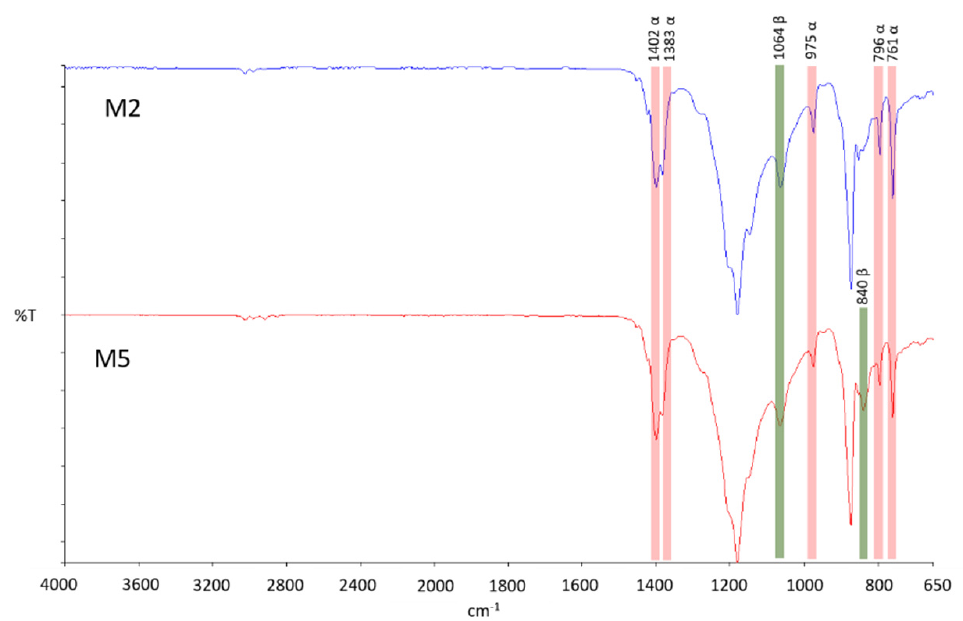
Figure 6. FT-IR spectra of PVDF membranes prepared in NMP (M2) and PolarClean ® (M5) as sol- vents.